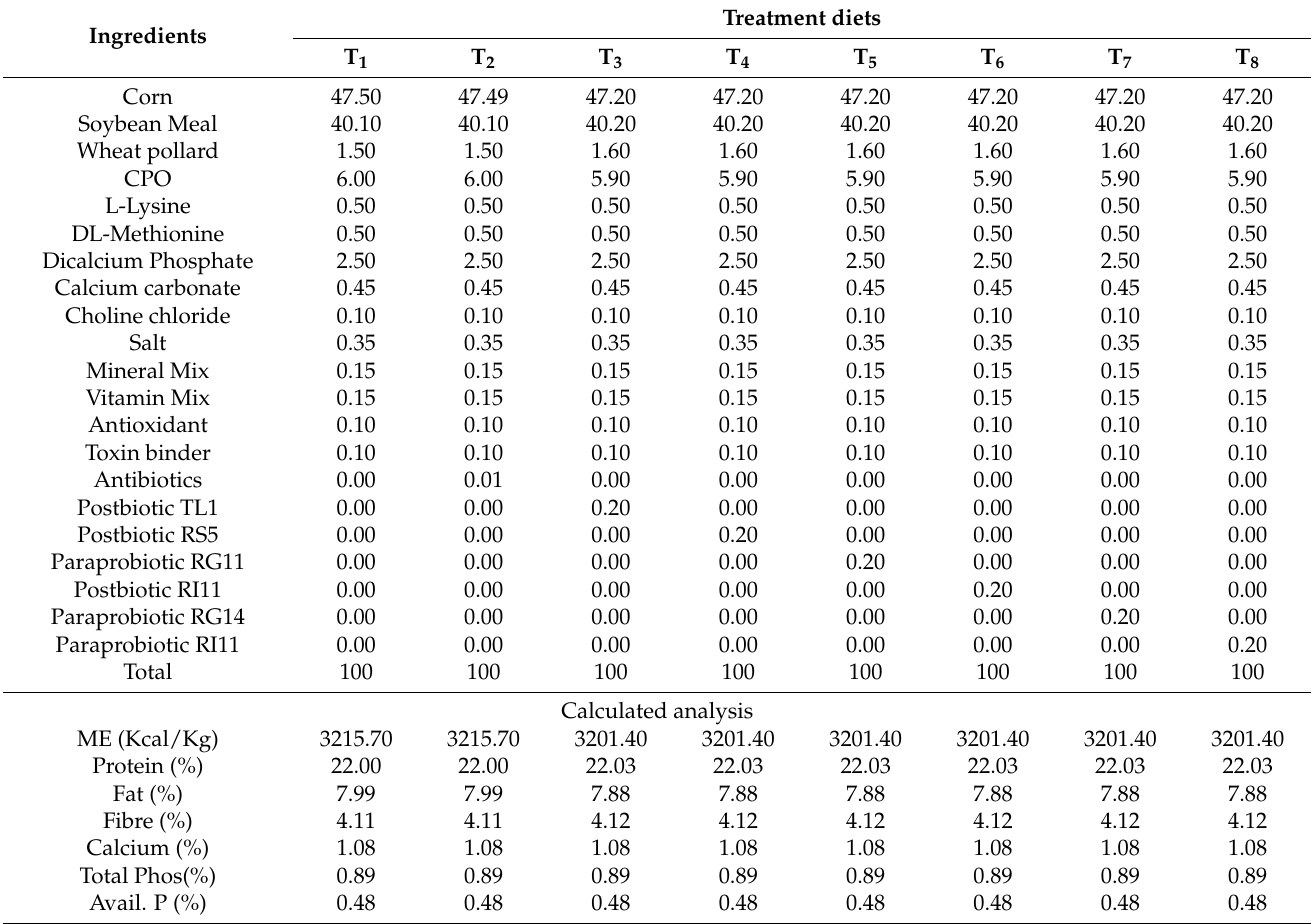
Table 1. Nutrient composition of starter diets (day